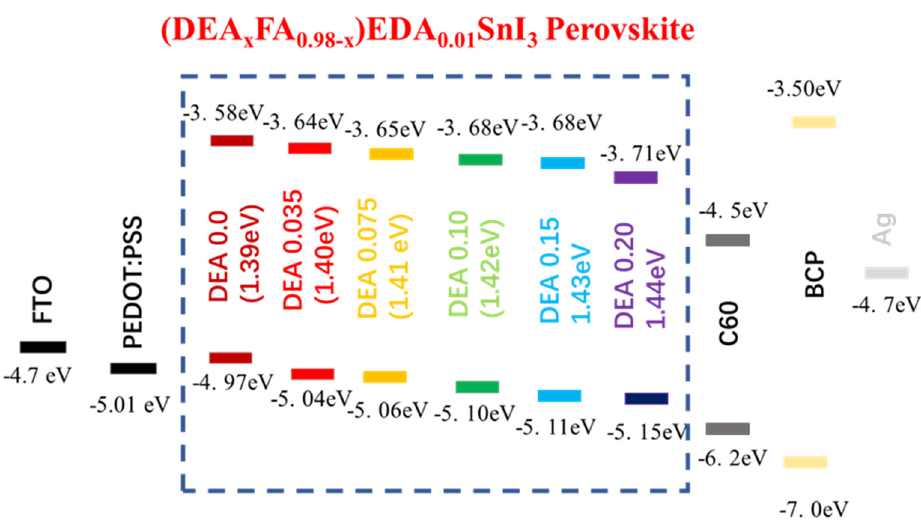
Figure 18. A–site substitution by DEA promotes a better energy cascade leading to improved photoelectric performance. Reproduced with permission [86]. Copyright 2021, Wiley VCH.